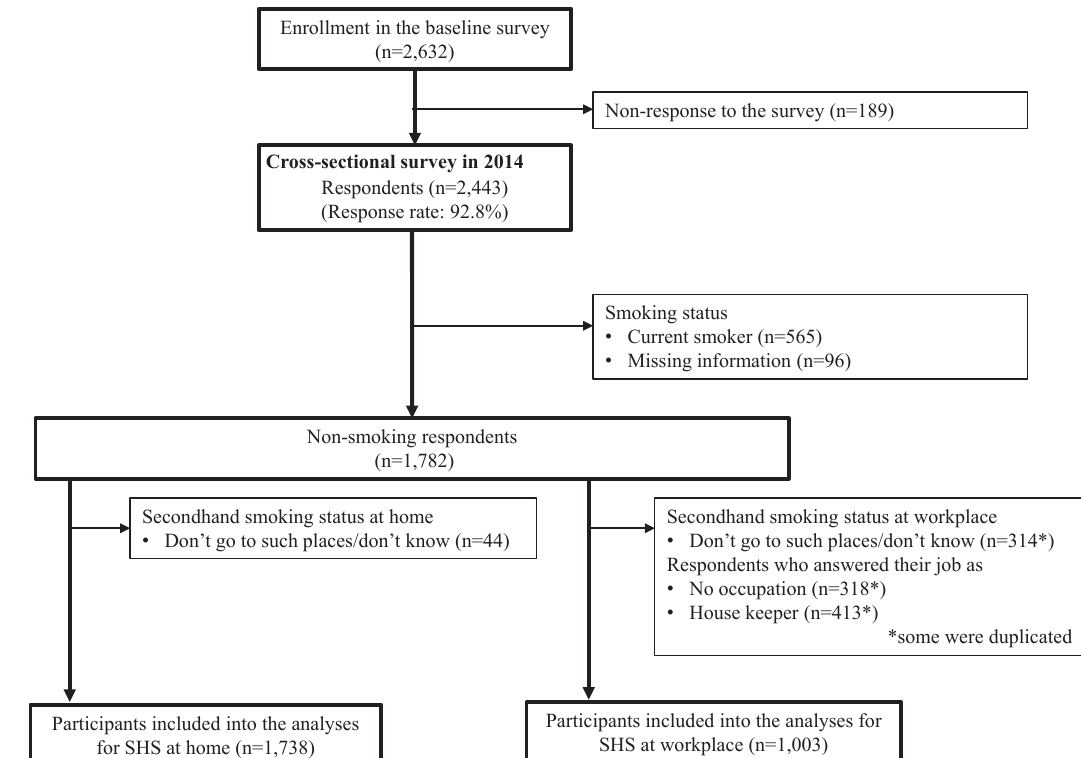
Figure 1. Flowchart of study participants. SHS, secondhand smoke.